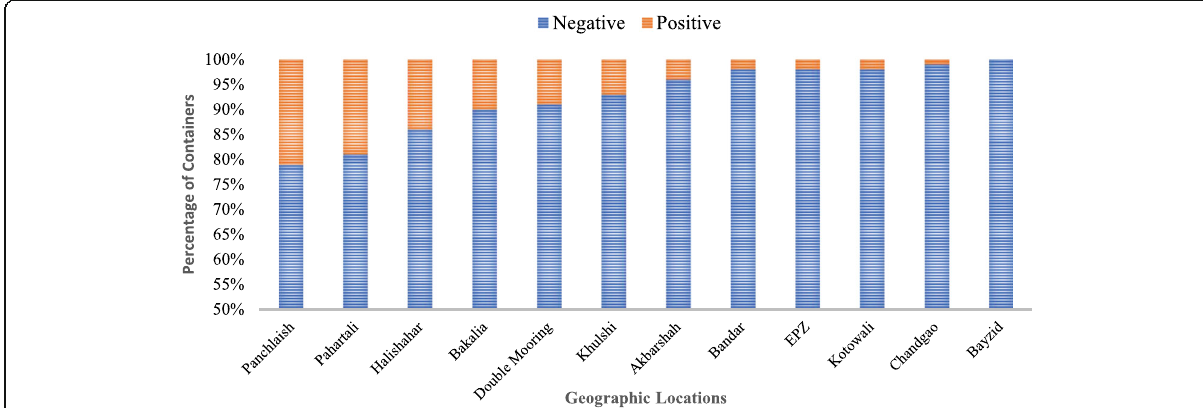
Fig. 2 Percentage of Aedes positive and negative containers in different geographical locations in Chattogram